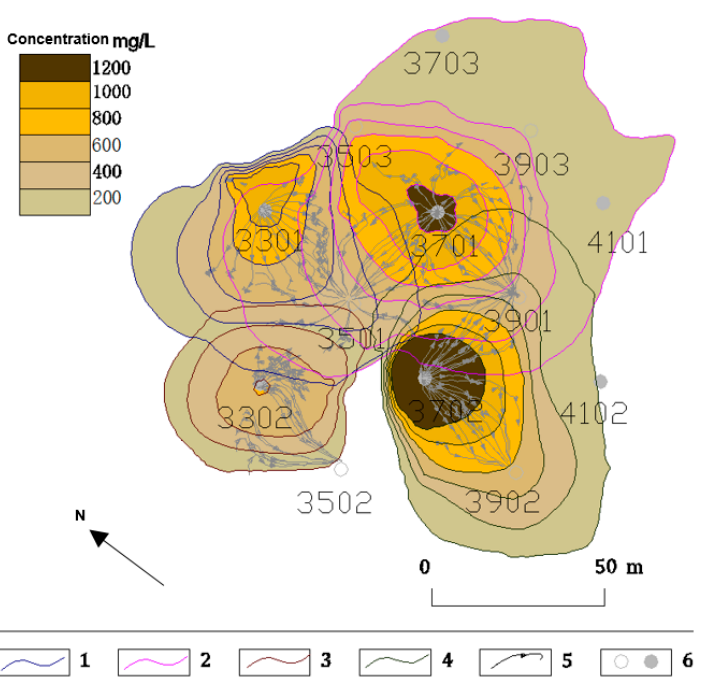
Figure 10. Solute migration distribution of unit 3501 on Day 32. (Note: 1—migration range of solute S3301; 2—migration range of solute S3701; 3—migration range of solute S3302; 4—migration range of solute S3702; 5—flow field streamlines of ISL of uranium; 6—pumping and injection wells in the